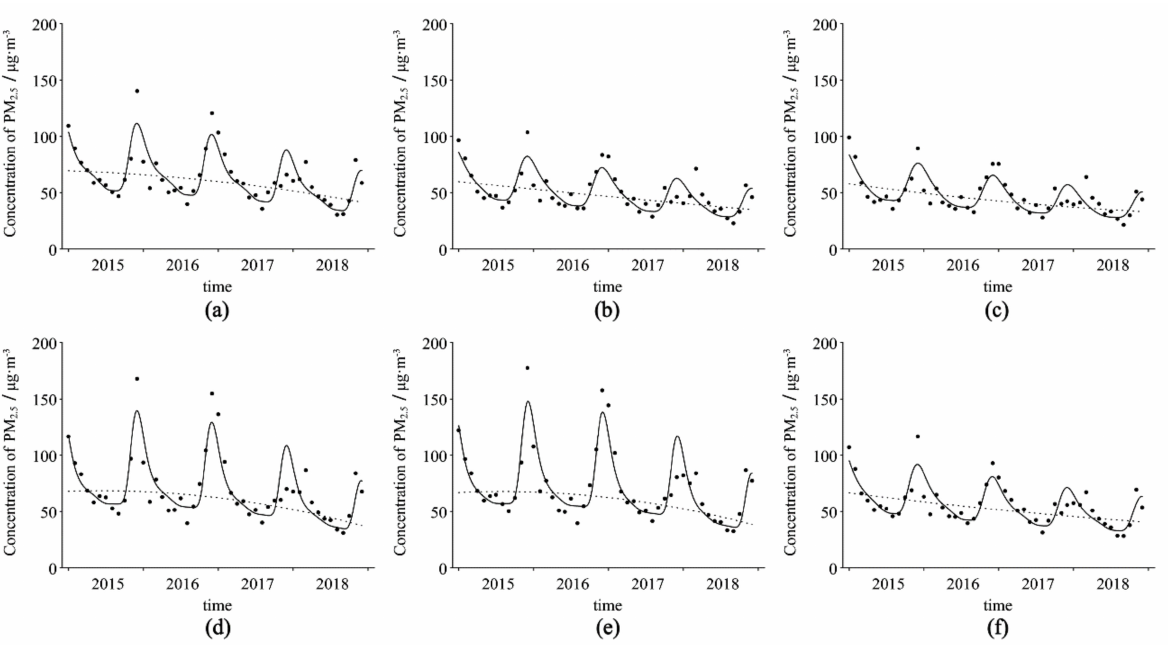
Figure 6. Fitting results of the monthly PM 2.5 concentration for each land use type: ( a ) water; ( b ) forestland; ( c ) grassland; ( d ) farmland; ( e ) construction land; and ( f ) unused land.